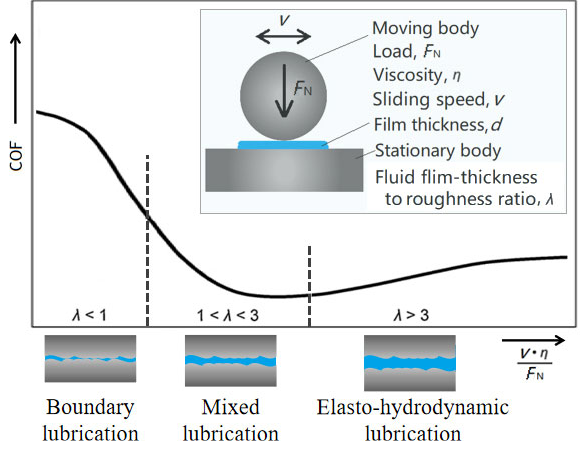
Fig. 13 Diagram of lubrication regimes in Stribeck